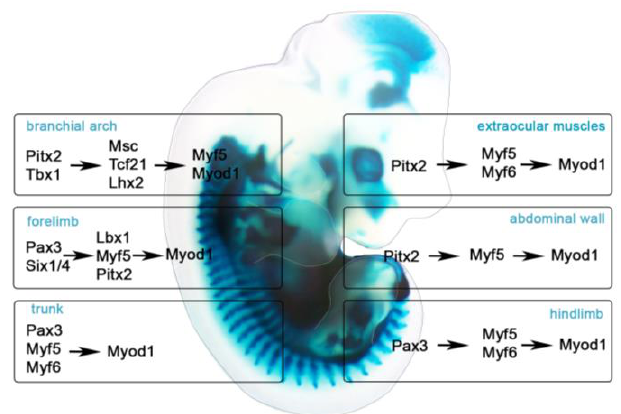
Figure 2. Gene Networks Involved in Muscle Specification. LacZ staining of E12.5 Pitx2 LacZ/+ mouse. Extraocular muscles (EOM) and abdominal wall muscles are specified by PITX2. Branchial arch muscles are specified by PITX2 and TBX1. Forelimb, trunk and hindlimb muscles are specified by PAX3.